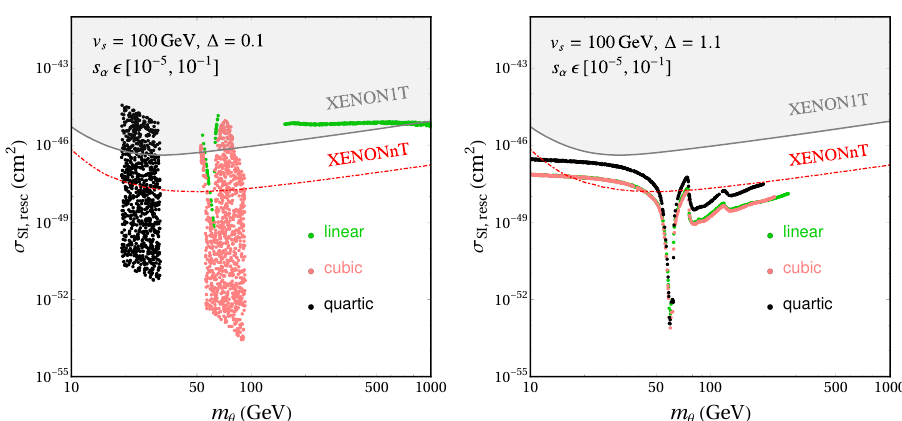
Figure 8. Scan in the rescaled spin-independent DD cross section signal for the minimal models versus the DM mass, for mixing in the range s ∆ = 0 . 1 (left, FDM) ∆ = 1 . 1 (right, ρ resonance). Constraints from perturbativity and